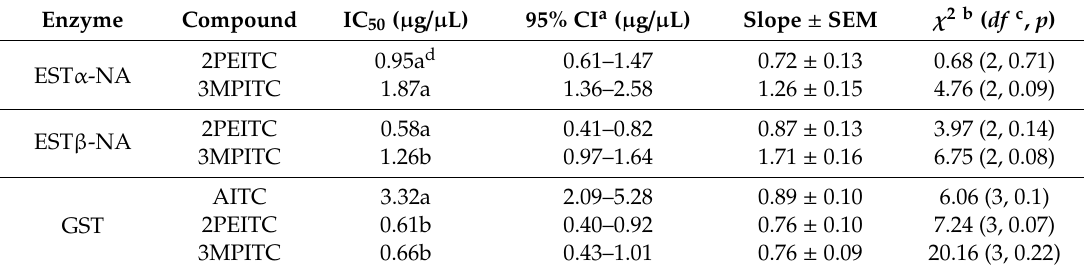
Table 3. IC 50 values of EST and GST inhibitory activity of three ITCs in S.